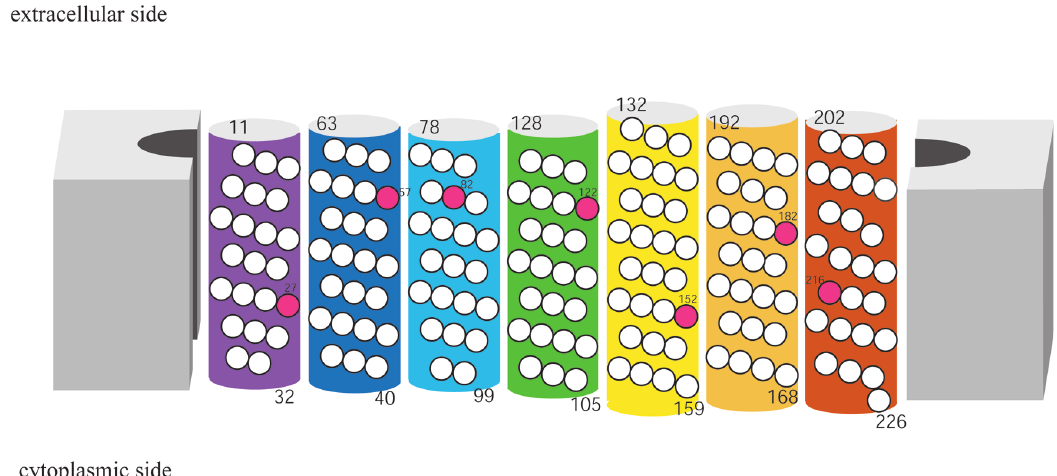
Figure S1. Schematic drawing of the 7TM bundle of MRs showing the proposed position of the *.50 residue in each helix (colored pink). The numbers attached to the helices are the selected ranges and the positions in the bR